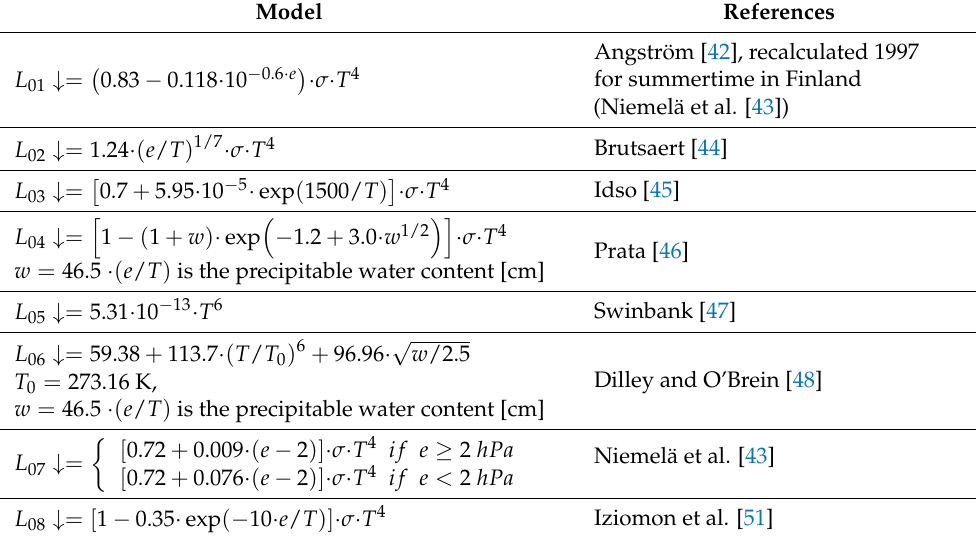
Table 11. Parameterizations of clear sky downwelling LW radiation, L 01 ↓ (W m − 2 ), as a function of the screen level temperature, T , expressed in ( ◦ K), and water vapor pressure, e , expressed in (hPa).